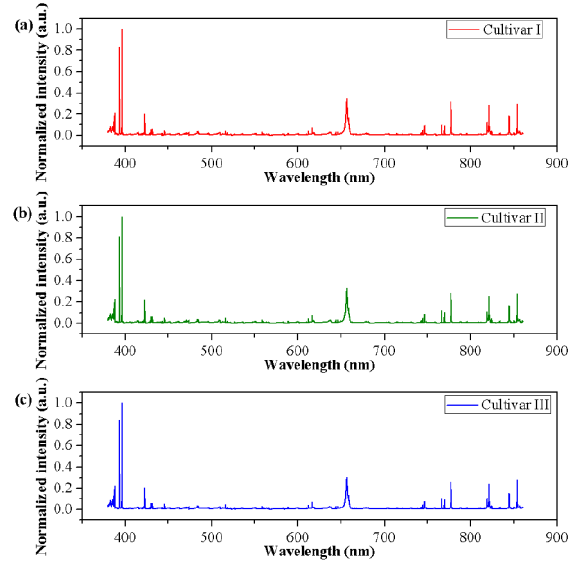
Figure 2. The normalized spectra of grape seeds of ( a ) Cultivar I, ( b ) Cultivar II, and ( c ) Cultivar III. The spectral ranged from 380.01–860.04 nm and the spectral intensities were transformed by min-max normalization.